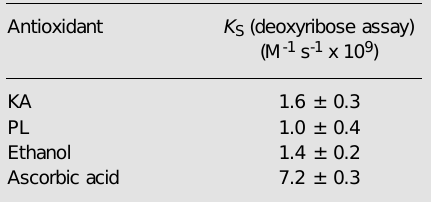
Table 1. Quenching activity of hydroxyl radical by PL and KA.